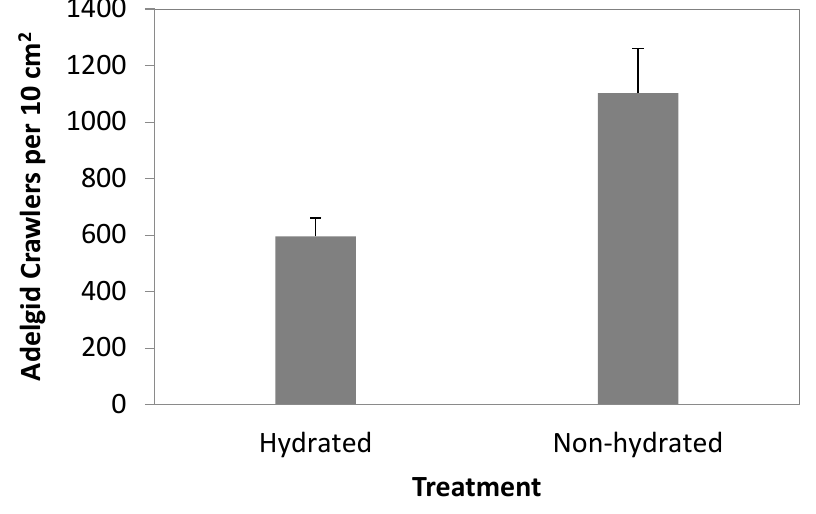
Figure 2. Total 10 day dispersal of hemlock woolly adelgid progrediens crawlers from hydrated and non-hydrated 10 cm long sistens infested eastern hemlock